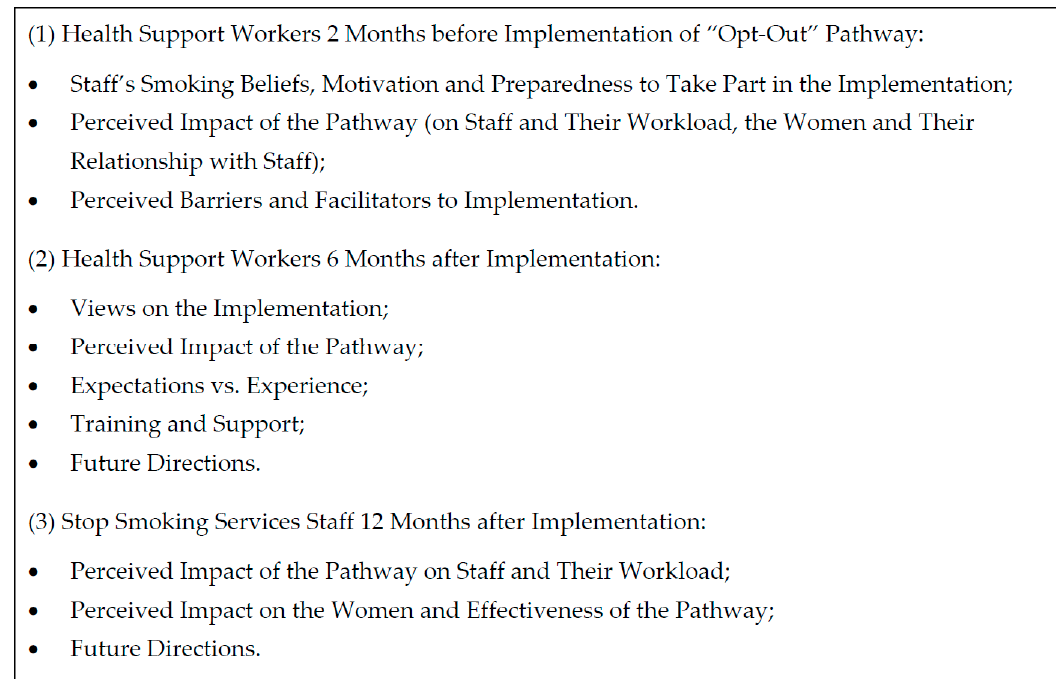
Figure 2. Interview topics. Figure 2. Interview